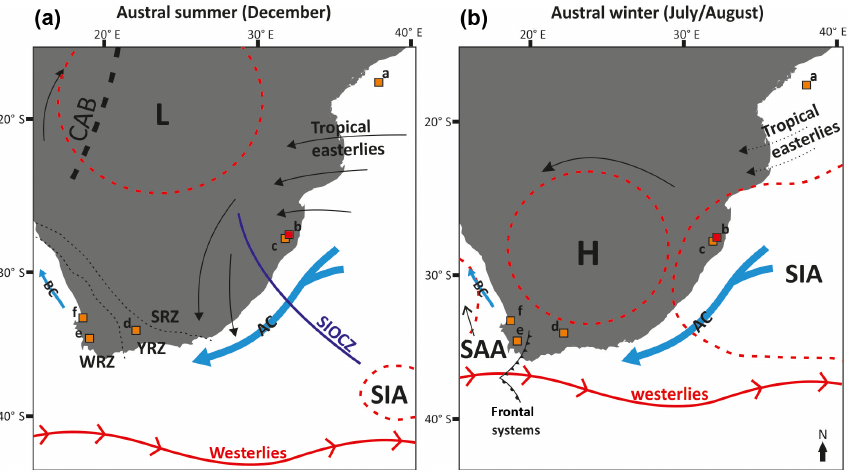
Figure 1. Map of South Africa in austral summer (a) and winter (b) showing the major oceanic and atmospheric currents and the position of the Congo Air Boundary (CAB). H (L): high- (low)-pressure systems. BC: Benguela Current. AC: Agulhas Current. Rainfall zones are shown in (a) : WRZ: winter rainfall zone, YRZ: year-round rainfall zone, and SRZ: summer rainfall zone. SIA: South Indian Anticyclone. SAA: South Atlantic Anticyclone. SIOCZ: South Indian Ocean Convergence Zone. Note that the westerlies move north during austral winter and that the high-pressure system dominates over much of the continent, suppressing rainfall in the SRZ. Squares represent the key study sites mentioned in the text (and shown in Figs. 4 and 5): (a) MD79257 (Sonzogni et al., 1998). (b) Mfabeni, this study (red square). (c) Lake St Lucia (Humphries et al., 2016). (d) Seweweekspoort (Chase et al., 2017). (e) Cecilia Cave (Baxter, 1989). (f) Klaarfontein (Meadows and Baxter, 2001) and Verlorenvlei (Carr et al., 2015), one location. Figure modified from Gasse et al.